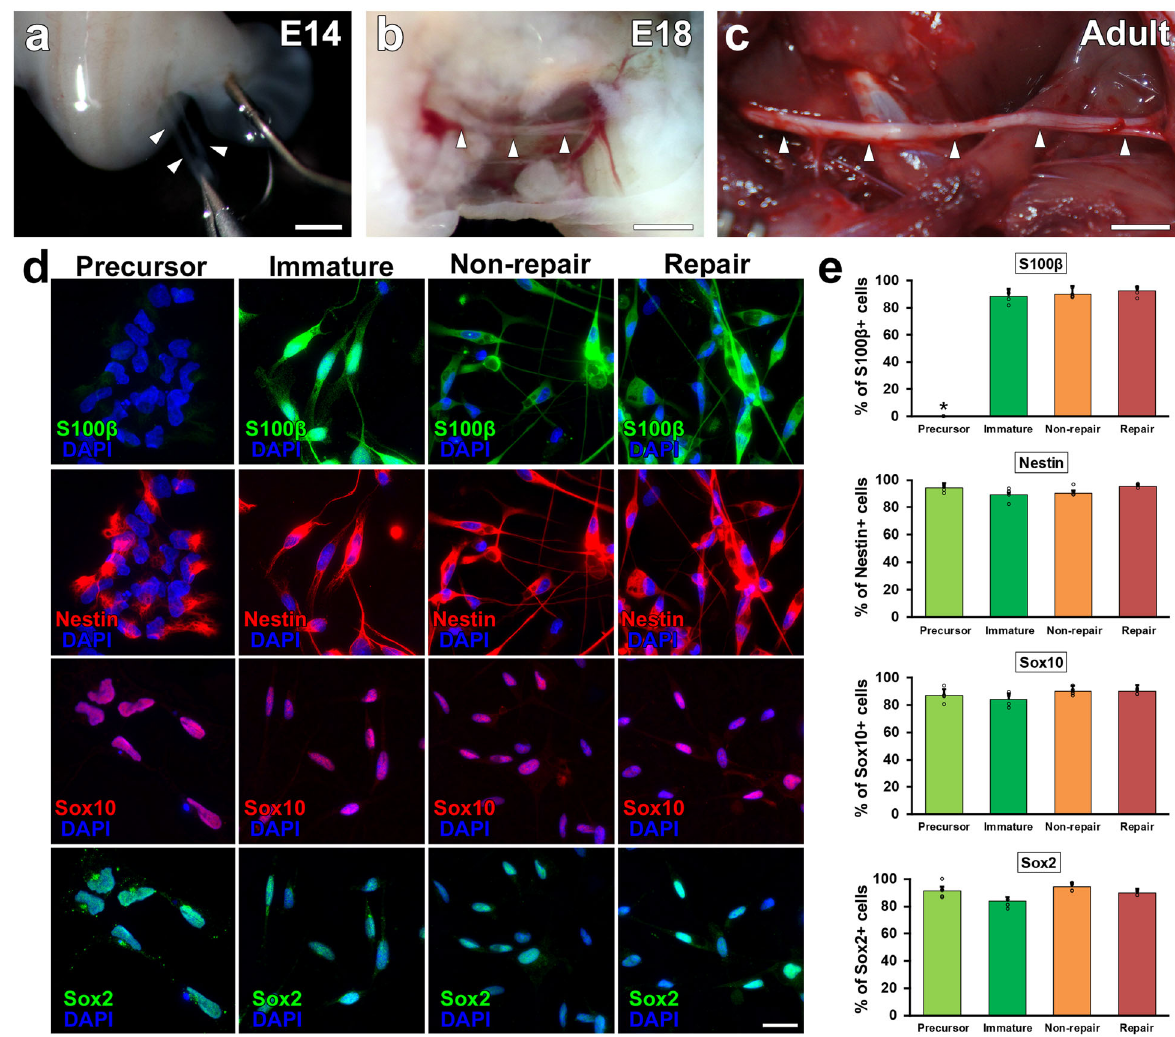
Fig. 1 Characteristics of prepared SCs. a – c Outlook of sciatic nerves at different developmental stages. SCPs, ISCs, and non-RSCs were harvested from intact sciatic nerves at E14 ( a ), E18 ( b ), and postnatal 10 – 12 weeks ( c ). Arrowheads indicate sciatic nerves. Scale bars: 1 mm ( a , b ), 5 mm ( c ). d Immunolabeling of cultured SCs against S100 β , Nestin, Sox10, and Sox2. Regardless of SC types, most cells express immature marker, Nestin and Sox2, and SC marker, Sox10. In contrast, another SC marker, S100 β is absent only in SCPs. Scale bars: 20 µm. e Quanti fi cations of % of immunolabeled SCs against S100 β , Nestin, Sox10, and Sox2. Five samples per group. At least 50 cells were counted in each sample. * P < 0.05 vs. SCP, one-way ANOVA with the Tukey – Kramer test. Error bars represent the (Fig. 1d) 36 – 38 . Based on Sox10 immunolabeling, the purity of